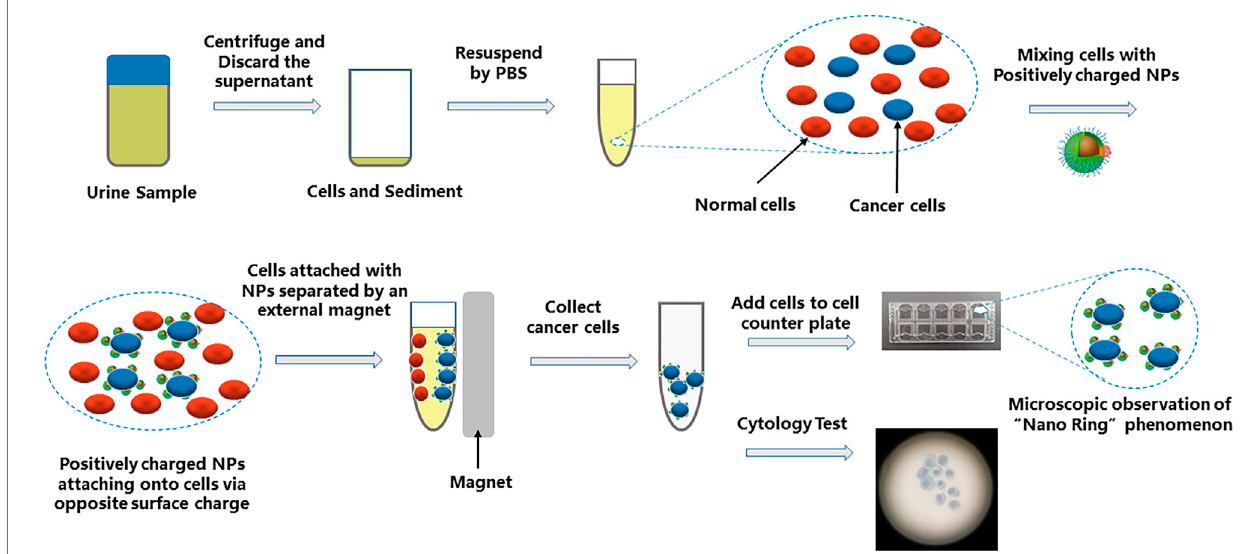
FIGURE 1 | Schematic diagram showing the procedure of Nano-cytology. The cells in suspension are mixed with positively charged NPs. Cell/NP bindings take place due to the opposite charges. The captured cells are magnetically attracted to the side of the tube by a permanent magnet. The “ Nano-ring ” phenomenon can be observed by a microscope. The collected cells also need a cytology